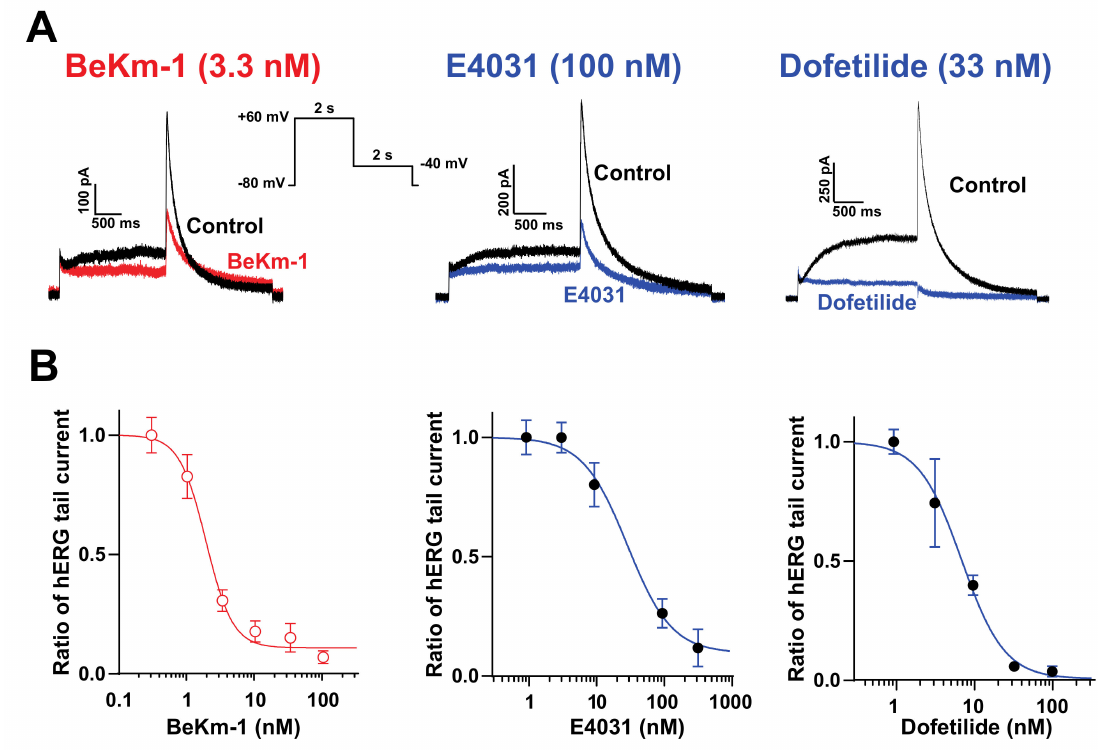
Figure 1. Block of hERG channels by BeKm-1 and comparison with other hERG high-a ffi nity blockers in HEK293 cells overexpressing hERG channels. ( A ) Voltage protocol for the stimulation of hERG channels and superimposed raw traces for I Kr currents in control conditions (black) or following treatment with hERG inhibitors (colored). The concentrations used for each drug are meant to show that the current block exceeds 50%. ( B ) Dose–response curve of hERG current inhibition by BeKm-1, dofetilide, and E4031. Data were fitted by a Hill equation yielding IC 50 values of 1.9 nM (BeKm-1, n = 44 cells), 7.2 nM (dofetilide, n = 34 cells) and 30.6 nM (E4031, n = 40 cells), and Hill numbers of 1.9 (BeKm-1), 1.6 (dofetilide) and 1.3